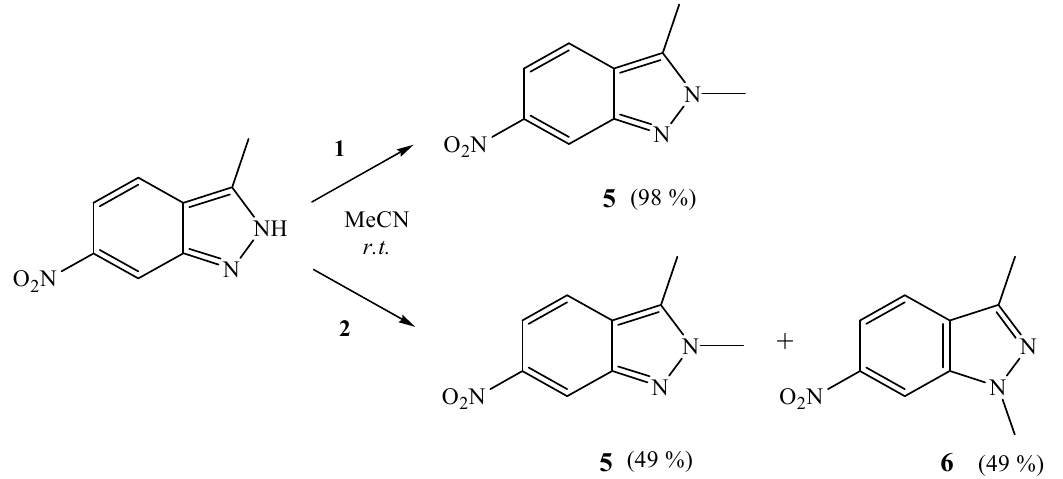
3. Methylation of 3-methyl-6-nitro-1 H -indazole by 9-dimethyloxonium and 10-dimethyloxonium derivatives of nido -carborane.